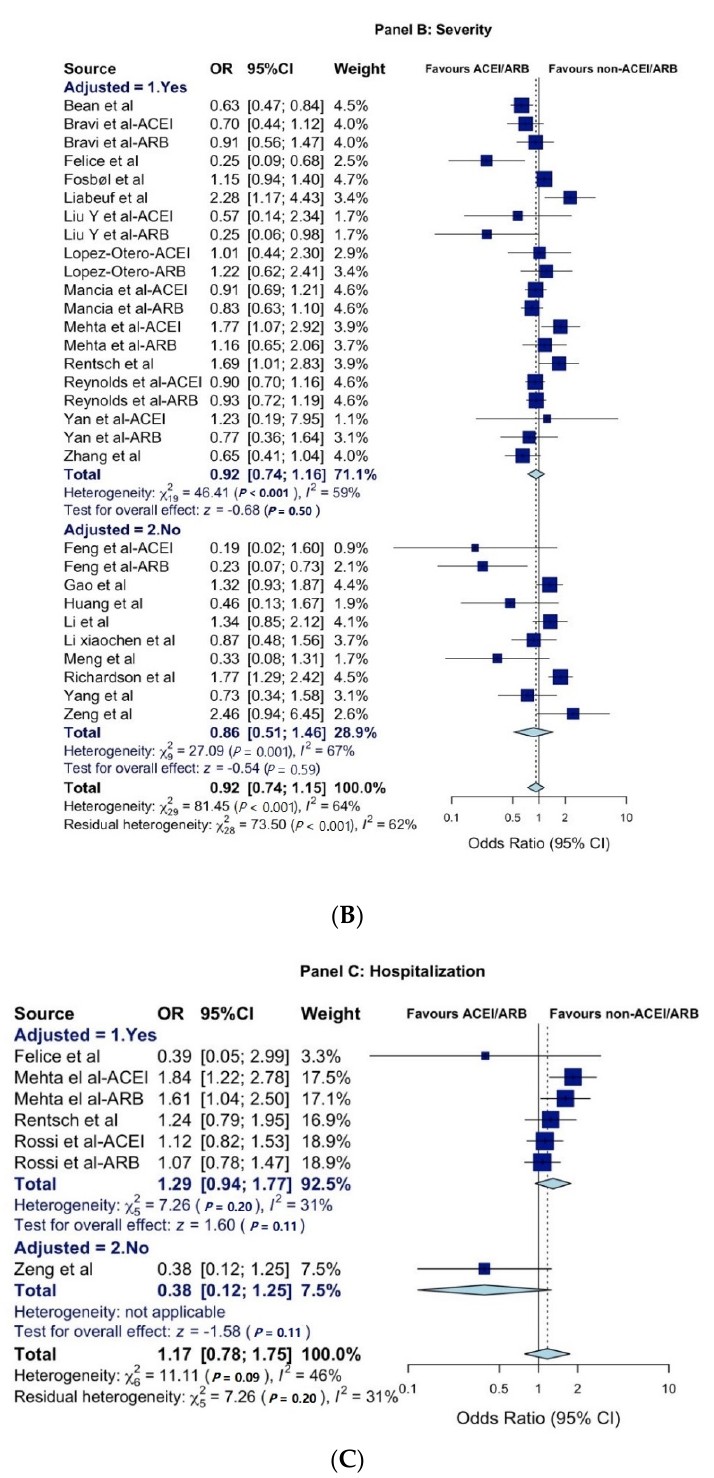
Figure 1. Forest plots for ( A ) mortality, ( B ) severity of COVID-19 disease, and ( C ) hospitalization. All studies were published in 2020. All citations included in the Supplementary Material Appendix to Table S1. The size of squares is proportional to the weight of each study. Horizontal lines indicate the 95% CI of each study; diamonds indicate the pooled estimate with 95% CI. Abbreviations: CI: confidence interval; OR: odds ratio. ACEI: Angiotensin-converting enzyme inhibitors. ARB: Angiotensin II receptor blockers.